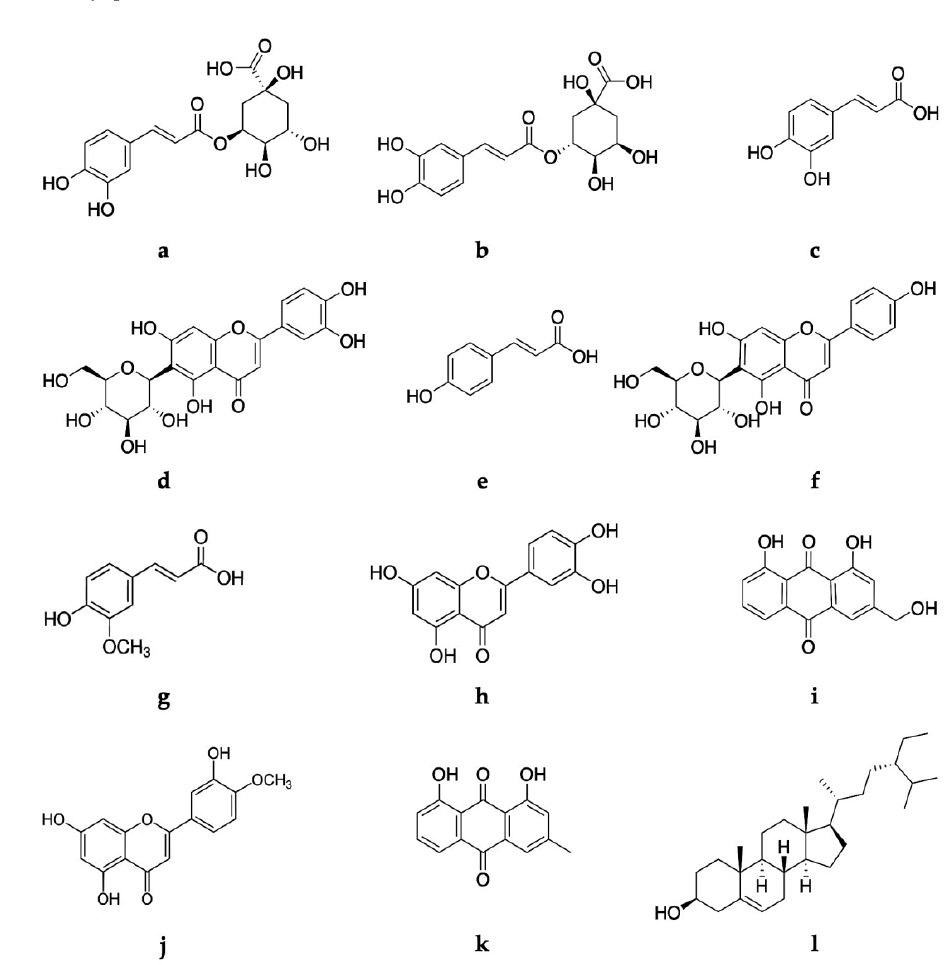
Figure 2. Structures of the marker secondary metabolites (a to l) from A. bento-rainhae and A. macrocarpus leaf extracts mentioned in Table 1.